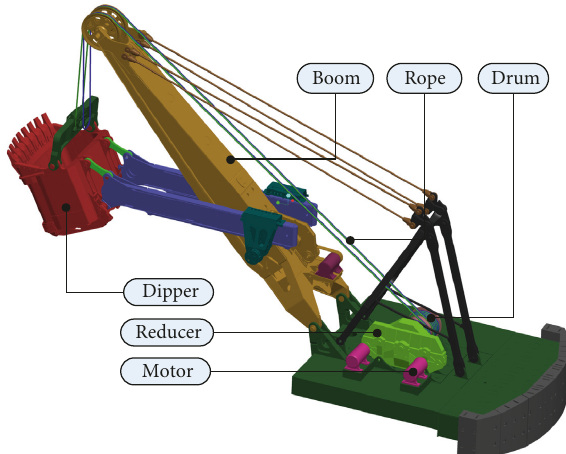
Figure 1: Structure diagram of EMS hoist system.